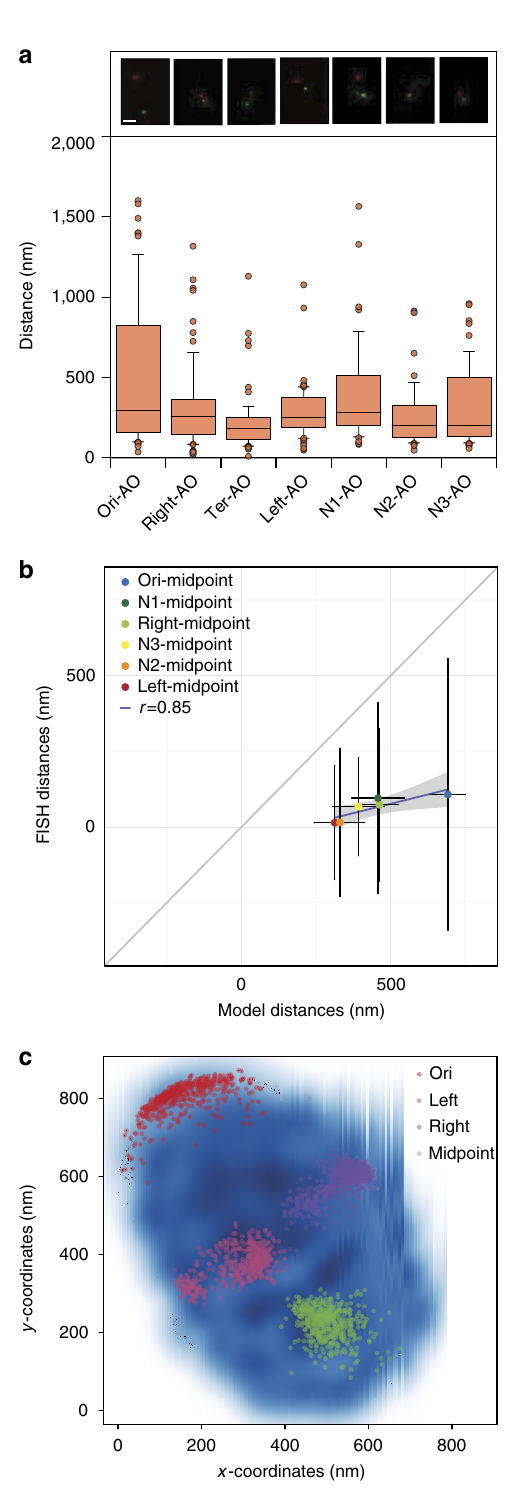
Figure 3 | Validation of 3D models with super-resolution imaging. ( a , top) FISH imaging with red (Alexa Fluor 568) indicating the genomic probes Ori, right, Midpoint, left, N1, N2 and N3, respectively, and green (Alexa Fluor 488) representing the P1 adhesin attachment organelle protein. Scale bar, 200nm. (bottom) Boxplot distribution and median distances estimated between the genomic probes and AO over B 50–70 cells. ( b ) Ori-midpoint, N1-midpoint, right-midpoint, N2-midpoint, N3-midpoint and left-midpoint estimated distances from chromosome models in the x axis and experimental FISH imaging in the y axis. Black lines indicate the variability within the estimated distribution. ( c ) 2D map representation of the chromosomal models from the first cluster shown in blue, with x and y coordinate positions shown in the x axis and y axis, respectively. Ori, left, right and midpoint positions across the first cluster of chromosome models are shown in red, pink, purple and green,